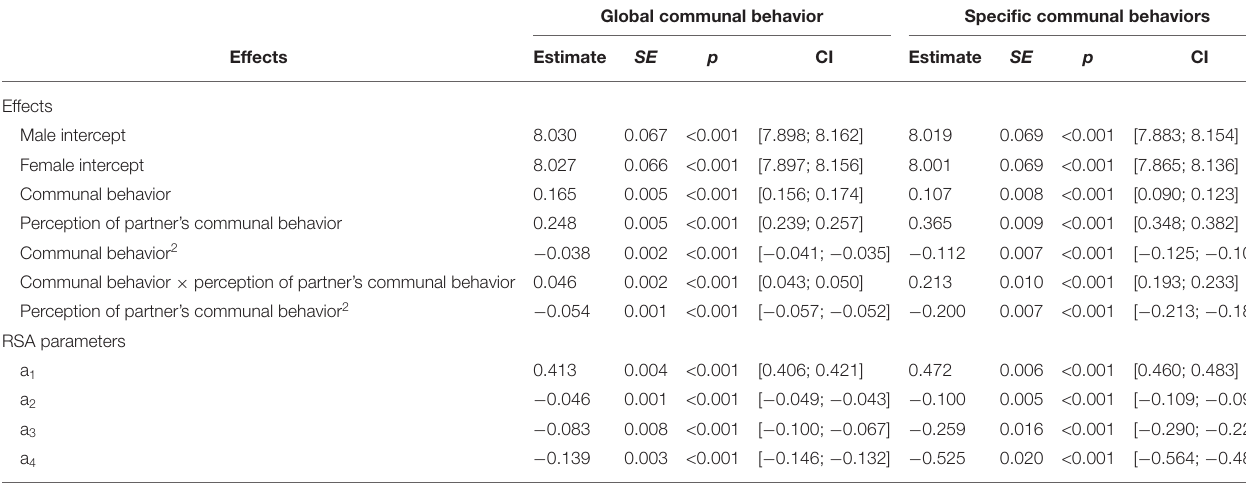
TABLE 5 | Results of multilevel response surface analyses for the prediction of relationship satisfaction by communal behavior and perceptions of the partner’s communal behavior.